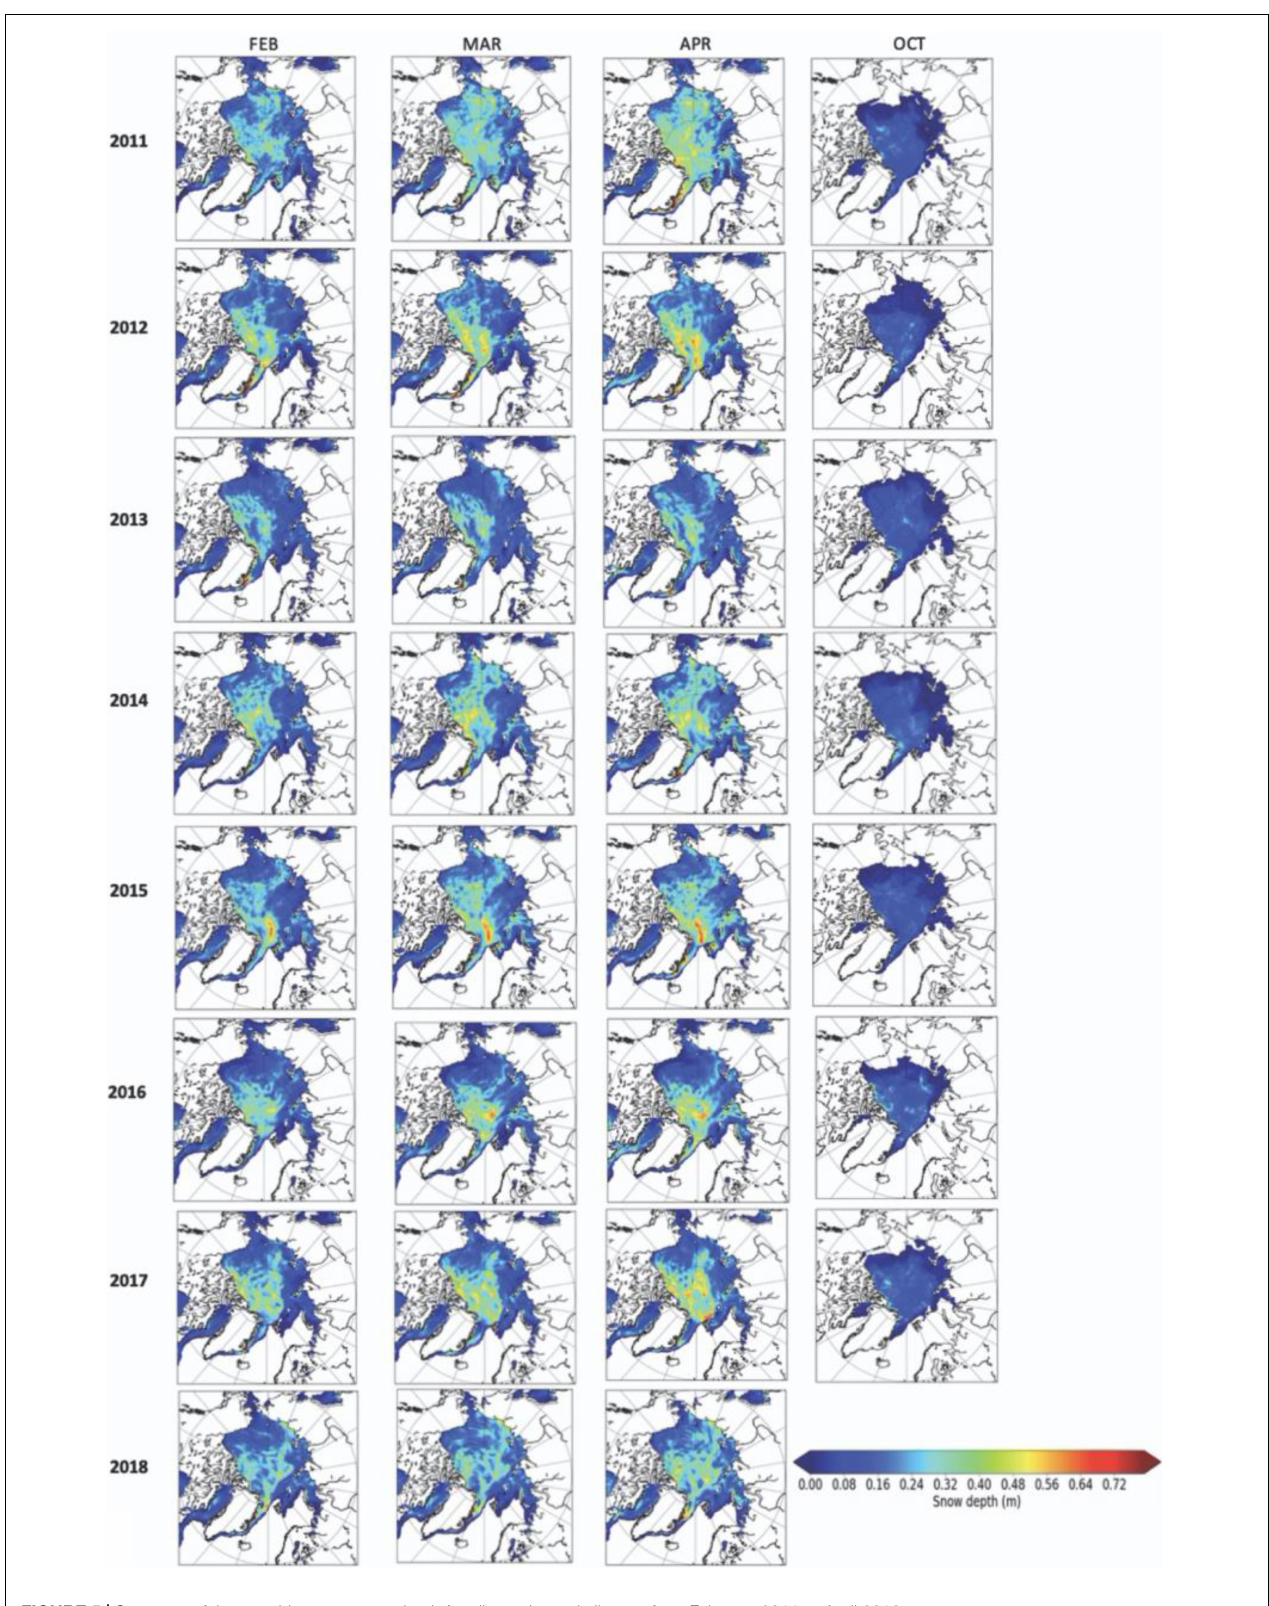
FIGURE 5 | Summary of the monthly mean snow depth for all months and all years from February 2011 to April 2018.